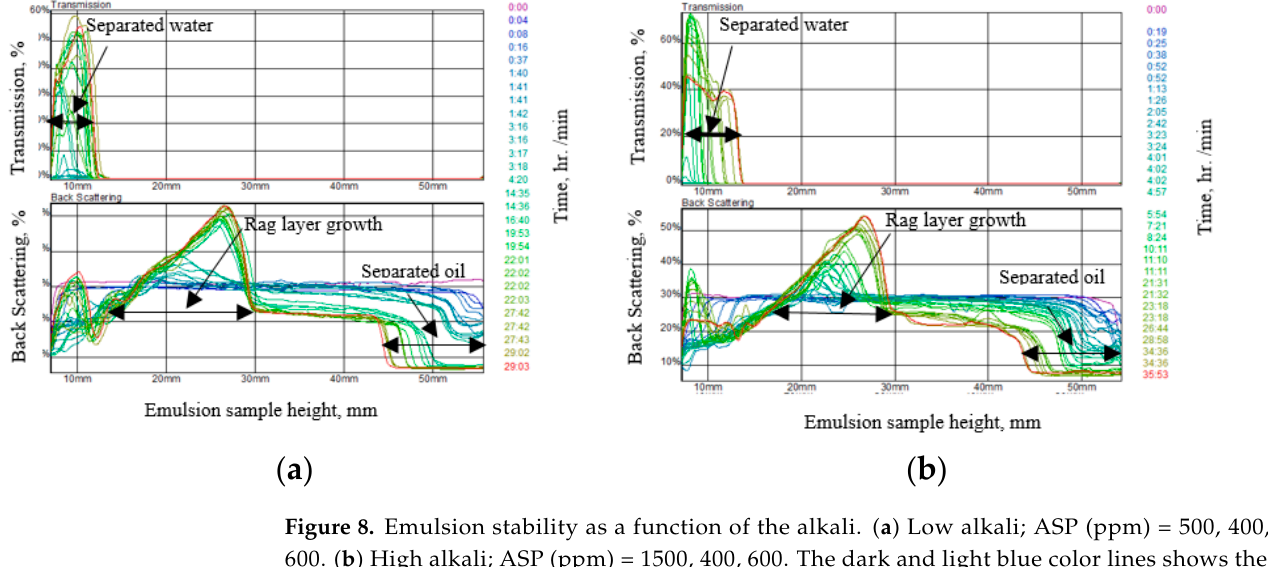
Figure 8. Emulsion stability as a function of the alkali. ( a ) Low alkali; ASP (ppm) = 500, 400, 600. ( b ) High alkali; ASP (ppm) = 1500, 400, 600. The dark and light blue color lines shows the initial measurement of emulsion stability values; red & yellow color lines shows final stability measurement values.